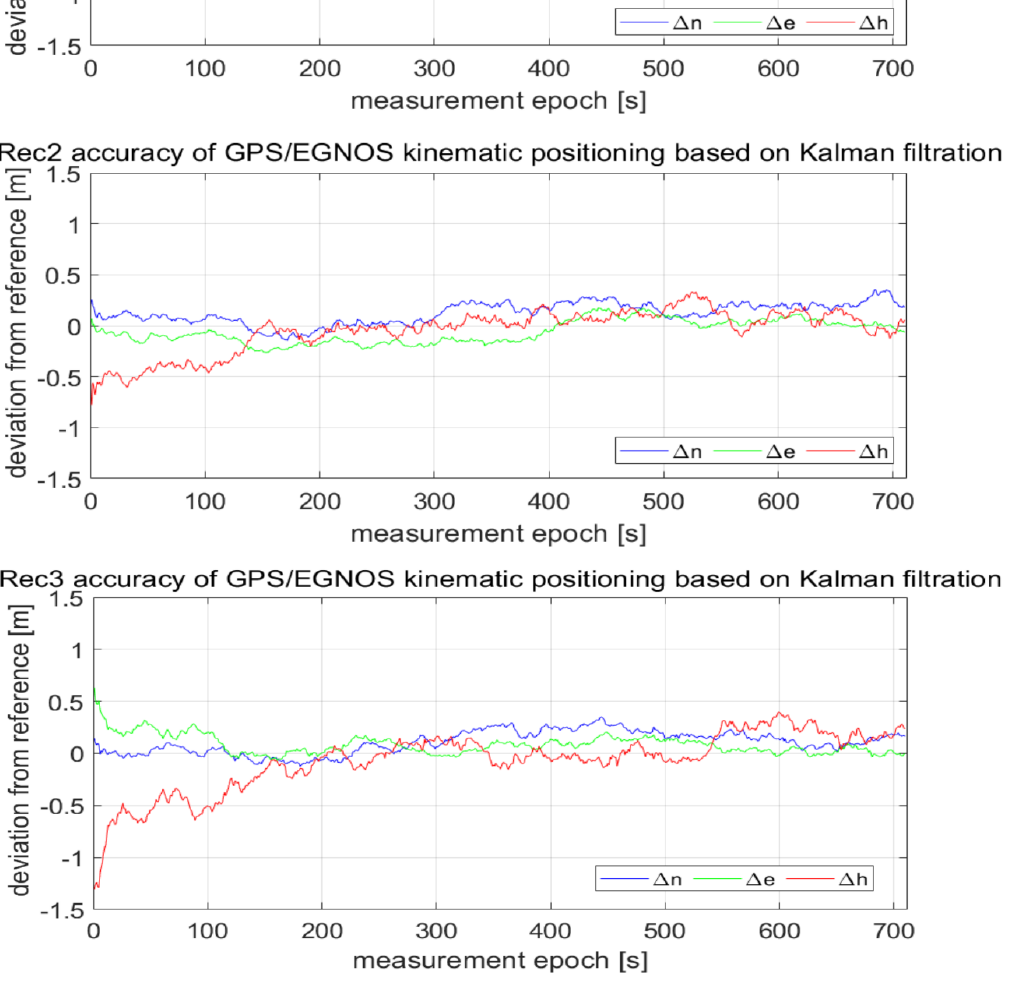
Figure 4. Accuracies of GPS kinematic positioning of individual receivers, by means of EGNOS correction and Kalman filtering.